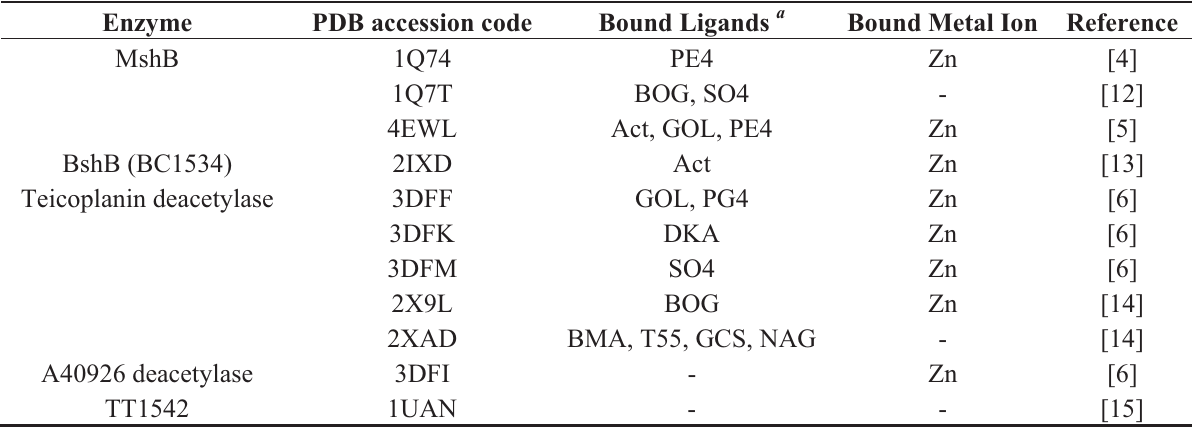
Table 2. Available crystal structures of LmbE-like